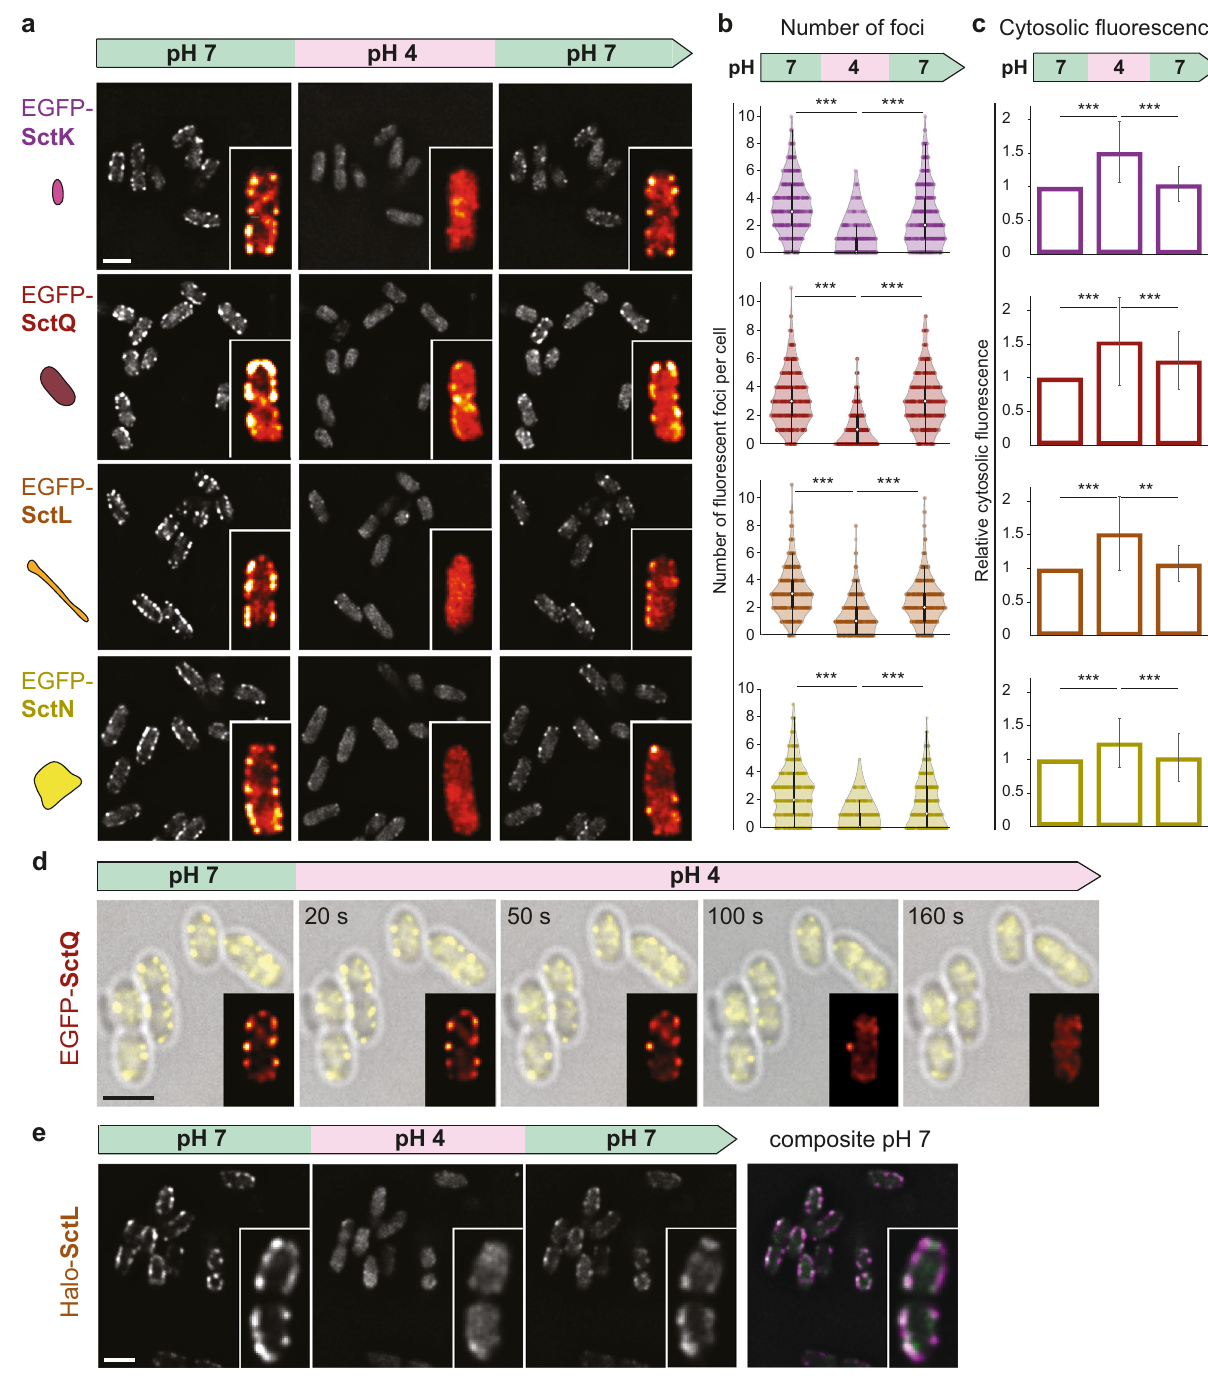
Fig. 2 The cytosolic T3SS components temporarily dissociate from the injectisome at low external pH. a Fluorescent micrographs of the indicated proteins in live Y. enterocolitica , consecutively subjected to different external pH in a fl ow cell. Images were taken under secreting conditions, 10 min after bacteria were subjected to the indicated pH. Insets, enlarged single bacteria, visualized with the ImageJ red-hot color scale. b Quanti fi cation of foci per bacterium for the strains and conditions shown in ( a ). n = 453, 792, 466, and 554 foci (from top to bottom) from three independent experiments. White circle denotes median, black bar denotes fi rst and third quartile, black line denotes the lower/upper adjacent value. c Quanti fi cation of mean cytosolic fl uorescence for the strains and conditions shown in ( a ). n = 75 cells from three independent experiments per strain. Bars denote mean values. For b , c error bars denote standard deviation; **/***, p < 0.01/0.001 in homoscedastic two-tailed t -tests ( b : p ~ 2 × 10 − 114 /2 × 10 − 57 , 4 × 10 − 102 /1 × 10 − 51 , 5 × 10 − 79 /1 × 10 − 69 , 8 × 10 − 89 /2 × 10 − 51 ; c : p ~ 8 × 10 − 18 /7 × 10 − 13 , 5 × 10 − 11 /2 × 10 − 3 , 2 × 10 − 13 /3 × 10 − 9 , 6 × 10 − 8 /4 × 10 − 4 for differences between pH for fi rst/second pH 7 incubation, respectively, from top to bottom). d Kinetics of EGFP-SctQ dissociation after pH shift from 7 to 4. Overlay of phase contrast (gray) and fl uorescence images (yellow); insets, enlarged single bacterium, visualized with the ImageJ red-hot color scale. e Fluorescence micrographs of Halo-SctL, labeled with JF 646 prior to the fi rst image, during consecutive incubation at different external pH as in ( a ). Right, overlay of fl uorescence distribution at pH 7 prior to and after pH 4 incubation (magenta and green, respectively). Experiments for a , d , and e were performed >5, >5, and 3 times, respectively, with comparable results. Scale bars, 2 μ